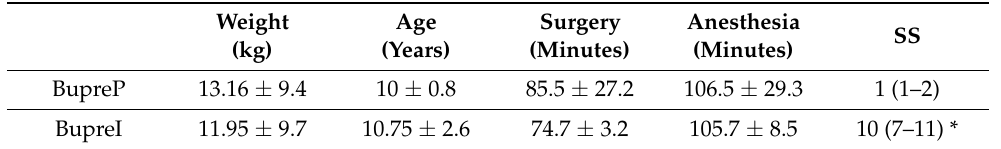
Table 2. Mean ± SD of weight, age, and duration of surgery and anesthesia in both groups. The sedation score (SS) was compared between the two groups 15 min before the induction (15 min after the administration of buprenorphine in BupreI group). * p <